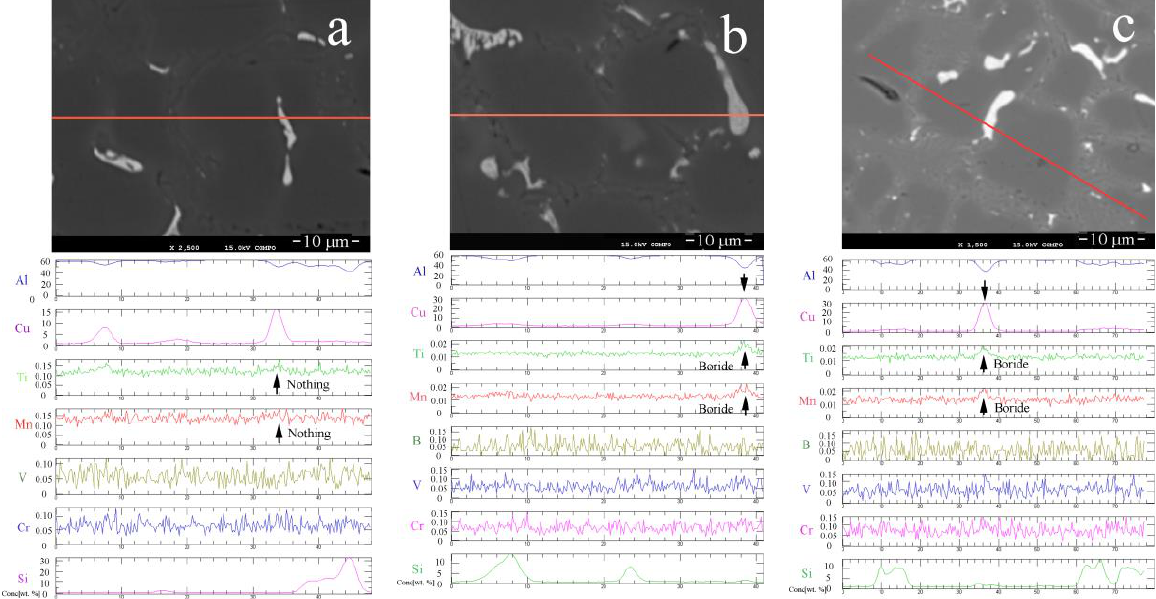
Figure 12. The line-scans of the major elements and trace elements measured byaJXA-8230 EMPA system for Al-9.8%Si-2%Cu containing: ( a ) no B; ( b ) 0.02% B; and ( c ) 0.05% B.